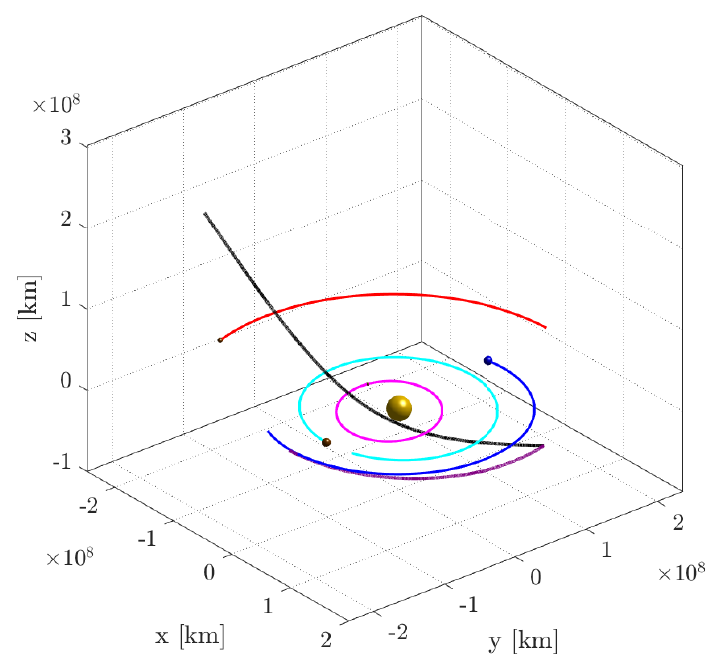
Figure 12. Three dimensional representation of the trajectories, in km of the ’Oumuamua (black) and the launched vehicle (purple) until the interception takes place. The orbits of Mercury (pink), Venus (light blue), Earth (dark blue) and Mars (red) are also plotted [31] (Courtesy